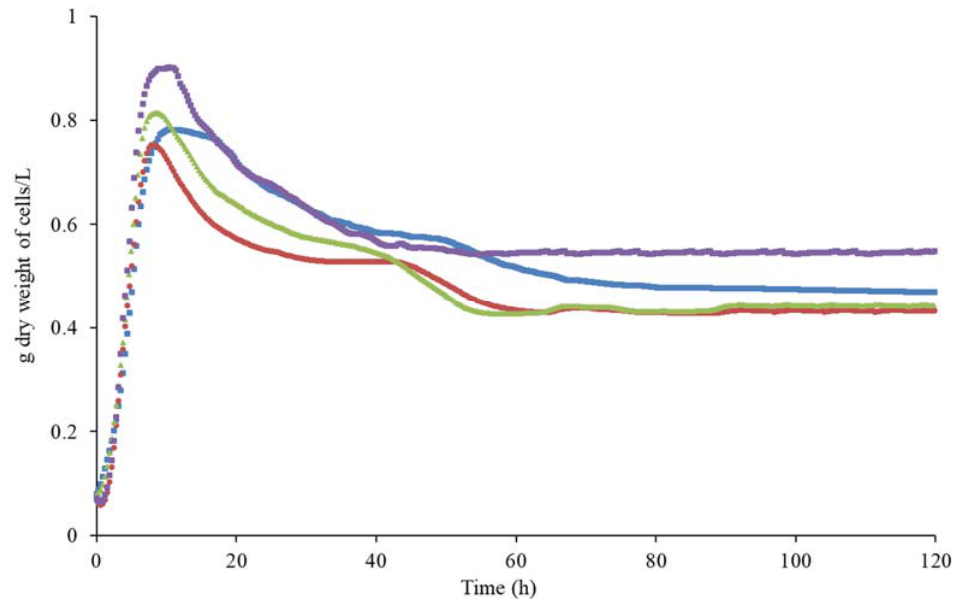
Figure 2. Cell growth of Clostridium carboxidivorans during syngas fermentation in the following media: ATCC® 2713 (blue square), ATCC® 2713 with 0.07% ( v/v ) Tween® 80 (red circle), ATCC® 2713 with 0.15% ( v/v ) Tween® 80 (green triangle), and ATCC® 2713 with 0.3% ( v/v ) Tween® 80 (purple square).